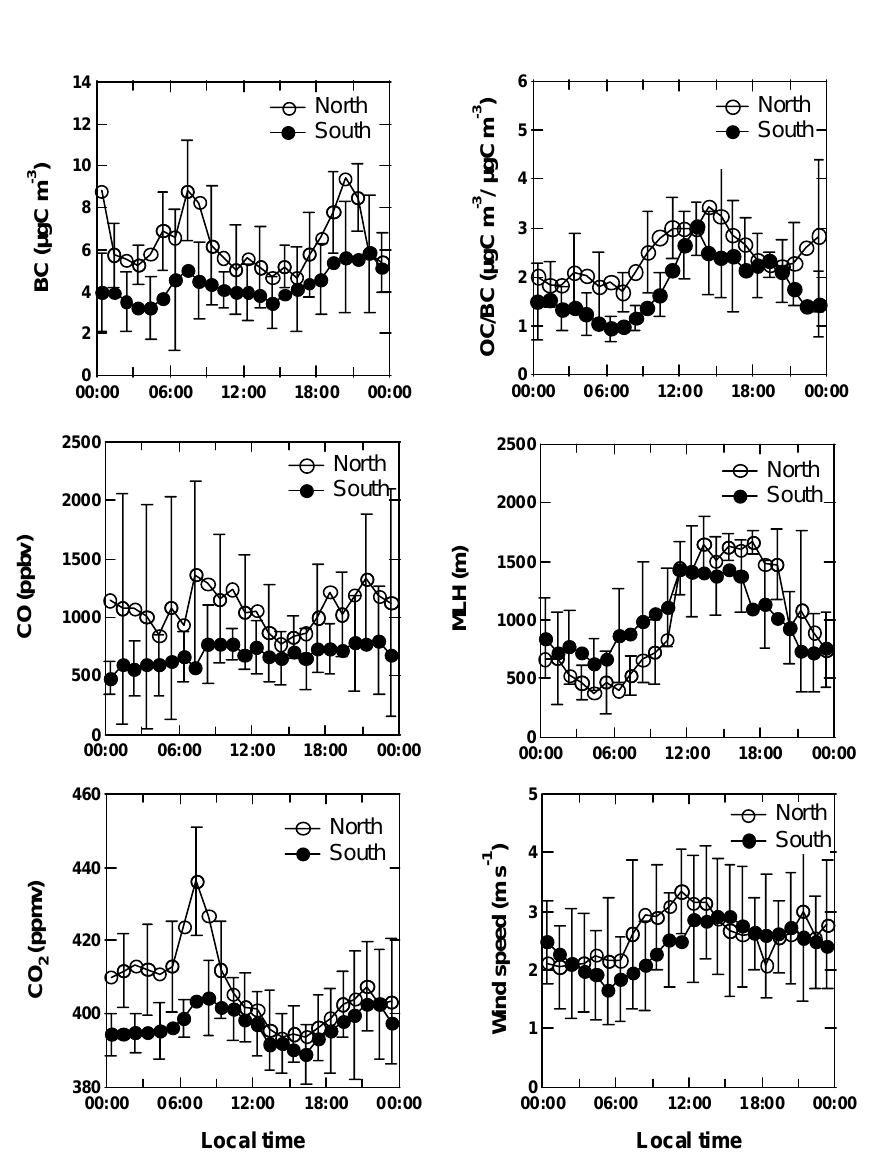
Fig. 5. Diurnal variations of hourly average ± SD of BC, CO, CO 2 , wind speed, mixed layer height (MLH), and the ratios of OC/BC in northerly and northerly air